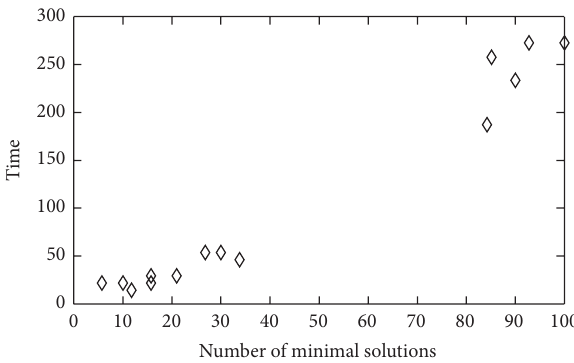
Figure 1: Number of minimal solutions versus execution time (in ms) reported in